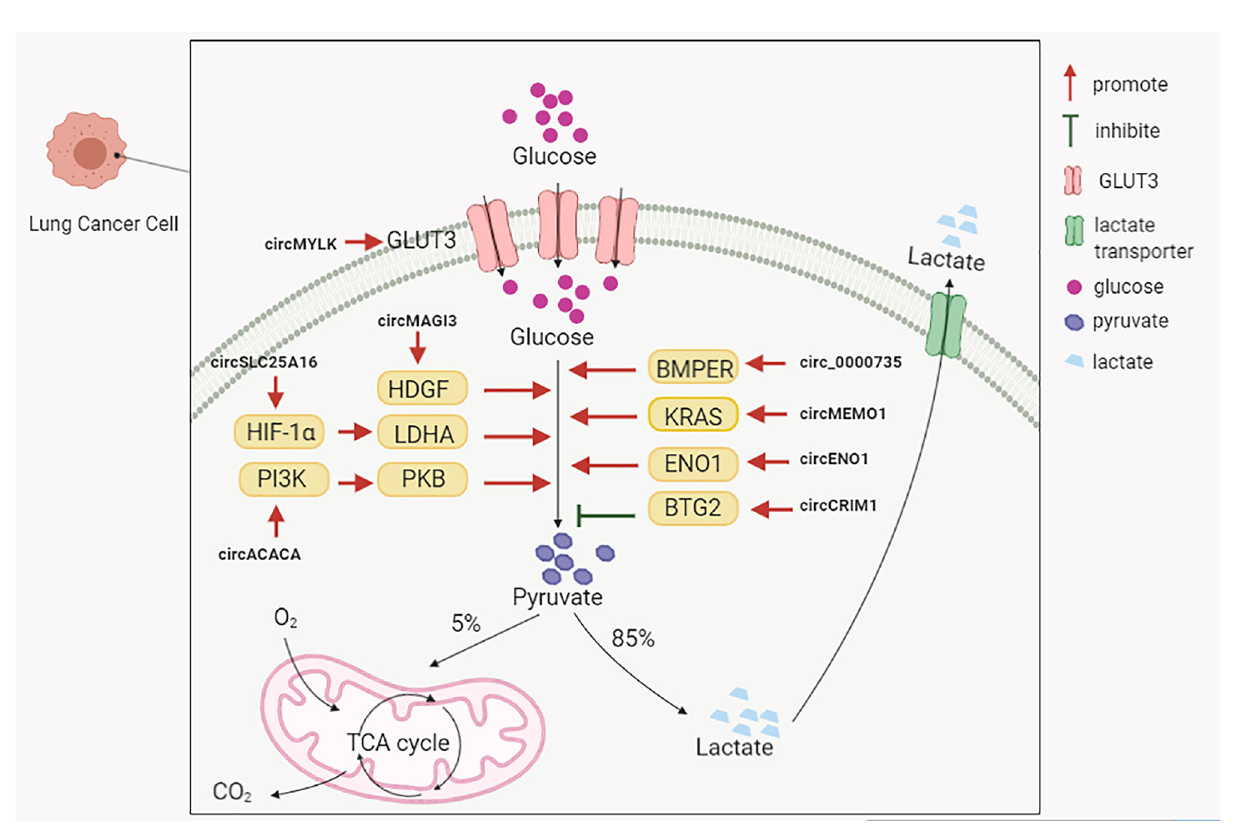
FIGURE 2 | The abnormal expression of circRNAs in lung cancer in fl uencing glycolytic